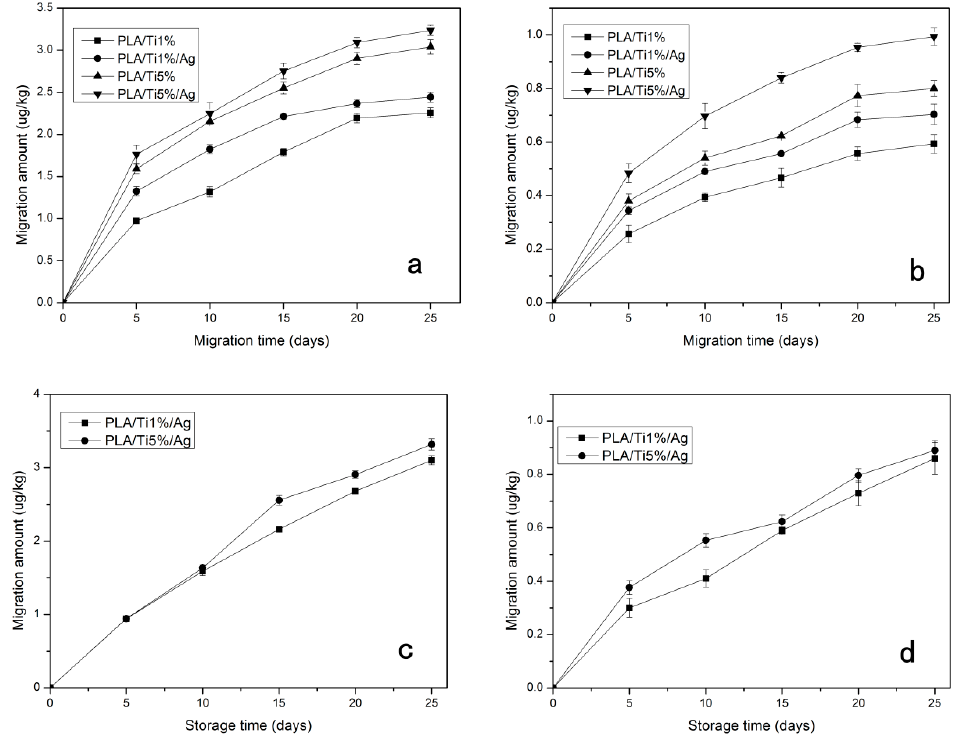
Figure 8. Migration of Ti from PLA/TiO 2 film into 3% ( w / v ) aqueous acetic acid ( a ) and 50% ( v / v ) aqueous ethanol ( b ); Migration of Ag from PLA/nano-TiO 2 /nano-Ag film into 3% ( w / v ) aqueous acetic acid ( c ) and 50% ( v / v ) aqueous ethanol ( d ).